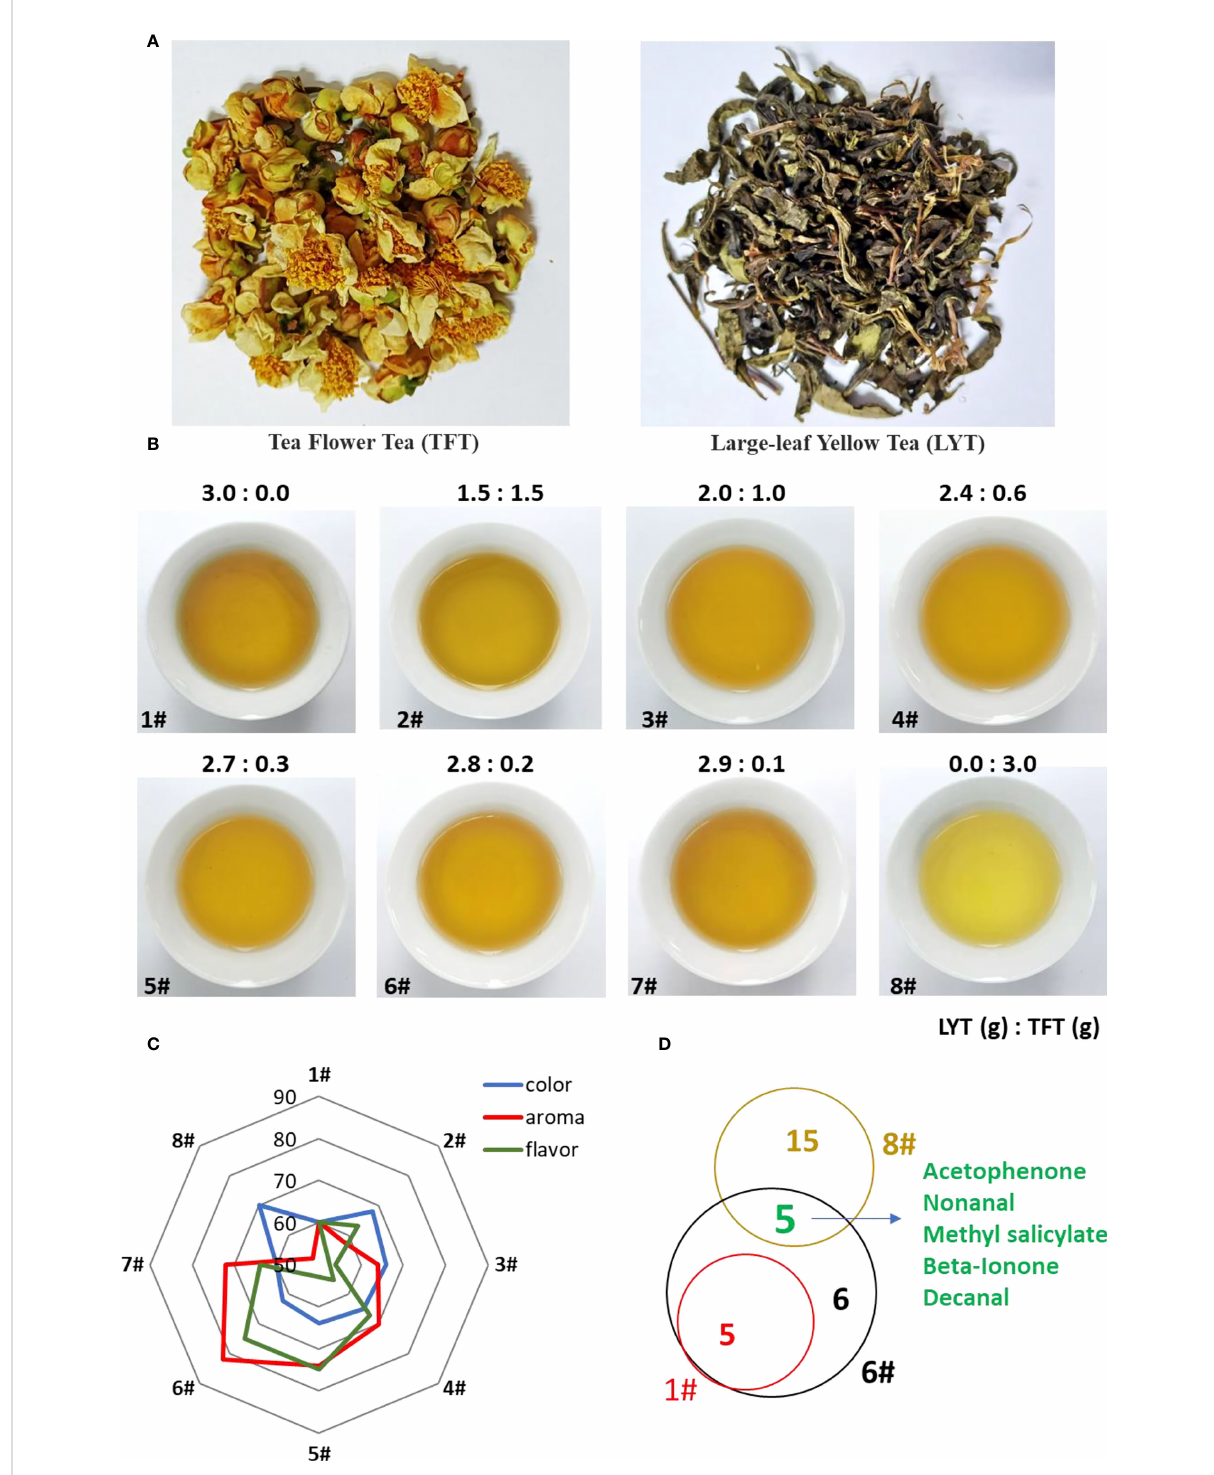
FIGURE 1 Potential application of tea fl owers in tea processing. (A) Appearance of tea fl ower tea products. TFT, tea fl ower tea; LYT, large-leaf yellow tea. (B) Soup color from mixed tea products with different ratios between TFT and LYT. The ratio number between TFT and LYT is listed on top of each fi gure. (C) Effect of TFT on taste attributes. (D) Venn diagram showing the volatile compounds of tea fl owers contributing to tea